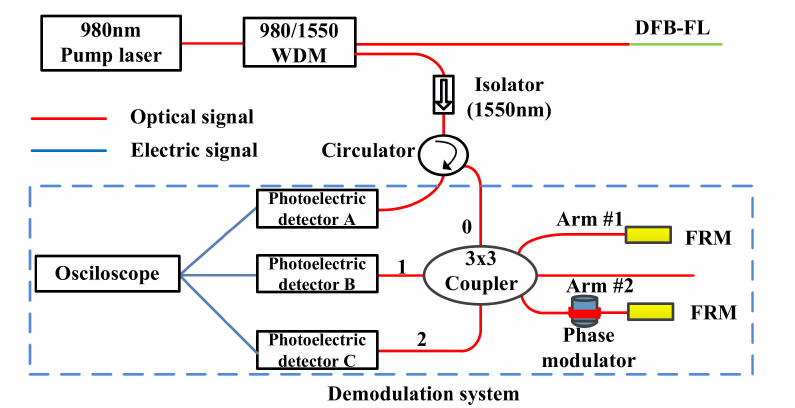
Figure 1. DFB-FL PD detection system (The ports of the 3 × 3 coupler are number annotated for subsequent algorithm